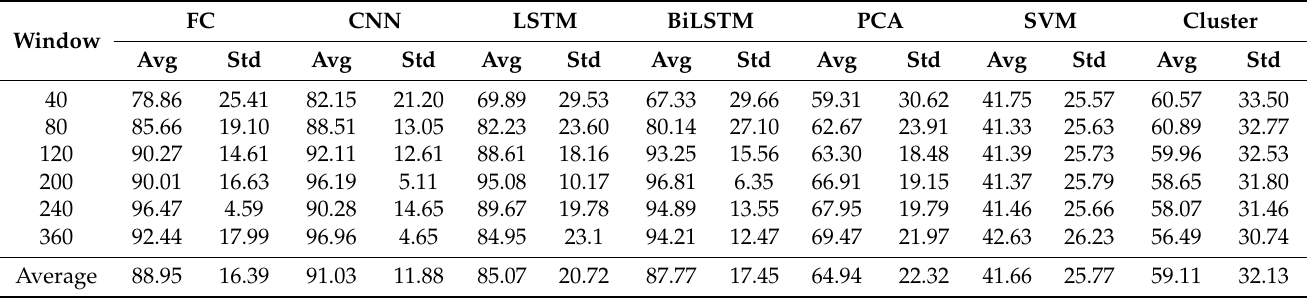
Table 9. Average F1 score and standard deviation for each window size in operating conditions with